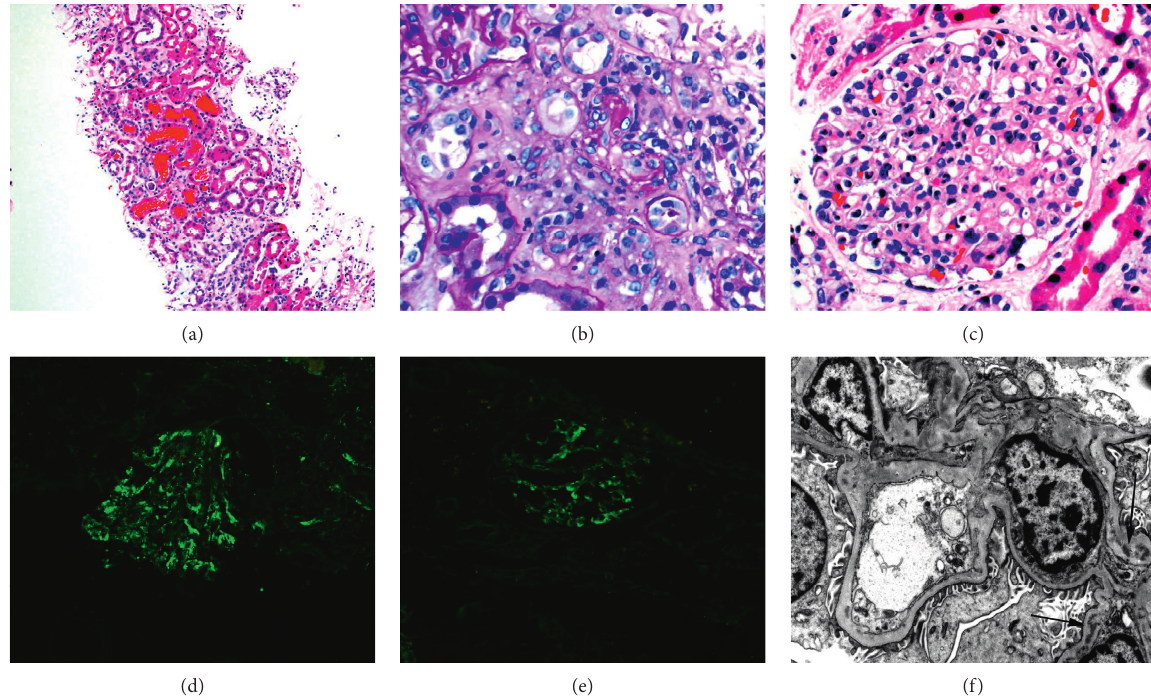
Figure 1: Renal biopsy demonstrating mild proliferative and exudative glomerulonephritis with IgM-dominant deposition consistent with infection-related glomerulonephritis. (a) Acute tubular injury with red blood cell casts. (b) Arteriolar hyalinosis. (c) Proliferative glo- merulonephritis with neutrophils. (d) IgM immune complex deposition. (e) C3 immune complex deposition. (f) Immune complex mesangial deposits on electron microscopy. Table 1: Sensitivities of Granulicatella adiacens .